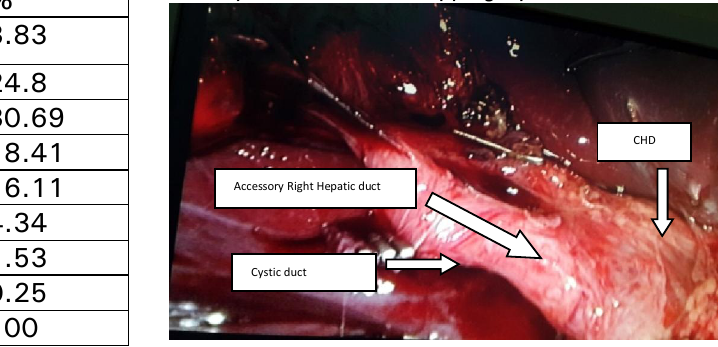
Picture 1: Accessory right hepatic duct continuous with cystic duct before clipping cystic duct.